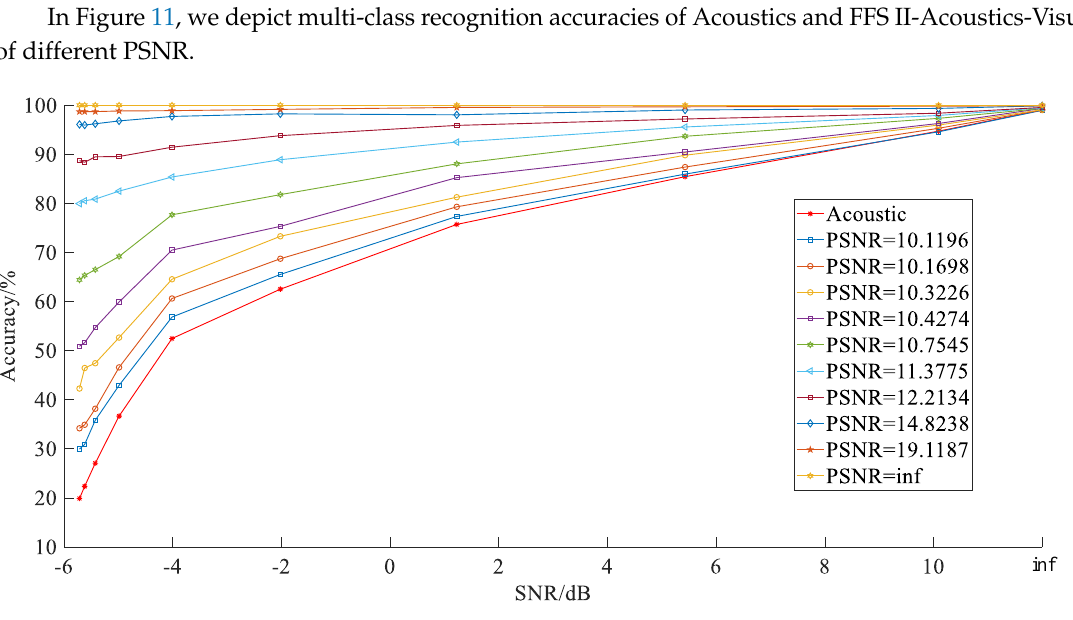
Figure 11. Recognition accuracies of Acoustics and FFS II-Acoustics-Visual of different peak signal-to-noise ratio